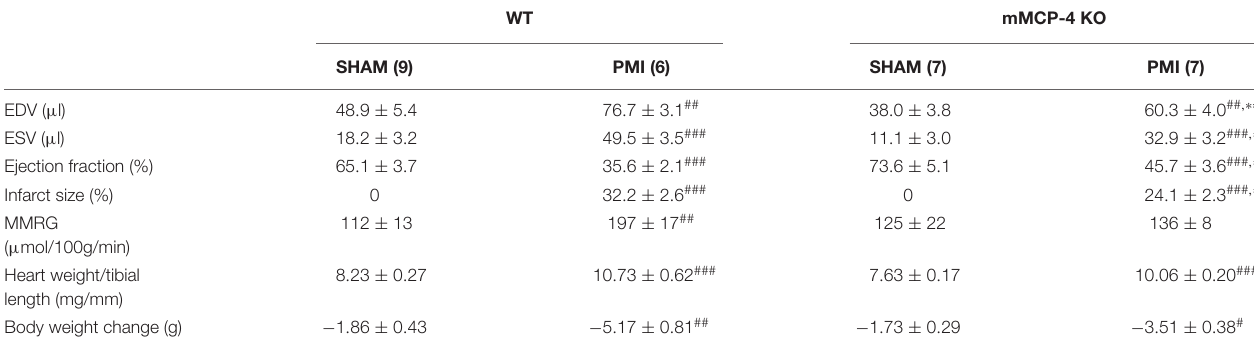
TABLE 2 | Left ventricular cardiac parameters and heart weight 3 days after surgery.